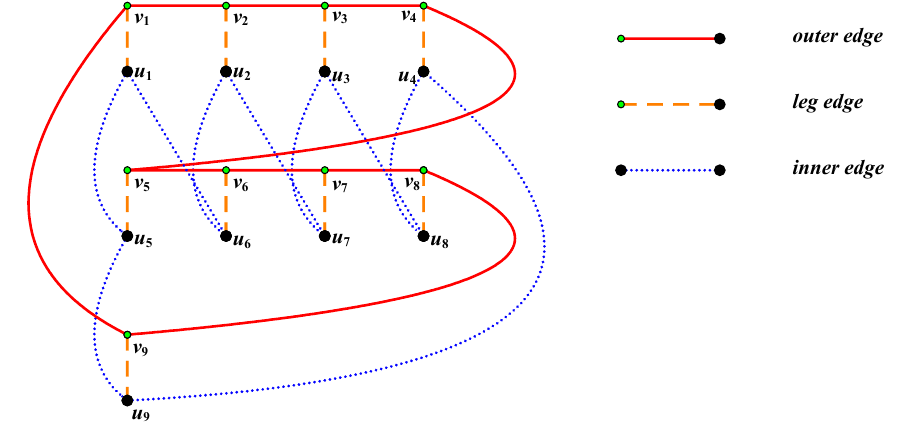
Figure 1. Illustrations of generalized Petersen graph P ( 9,4 )